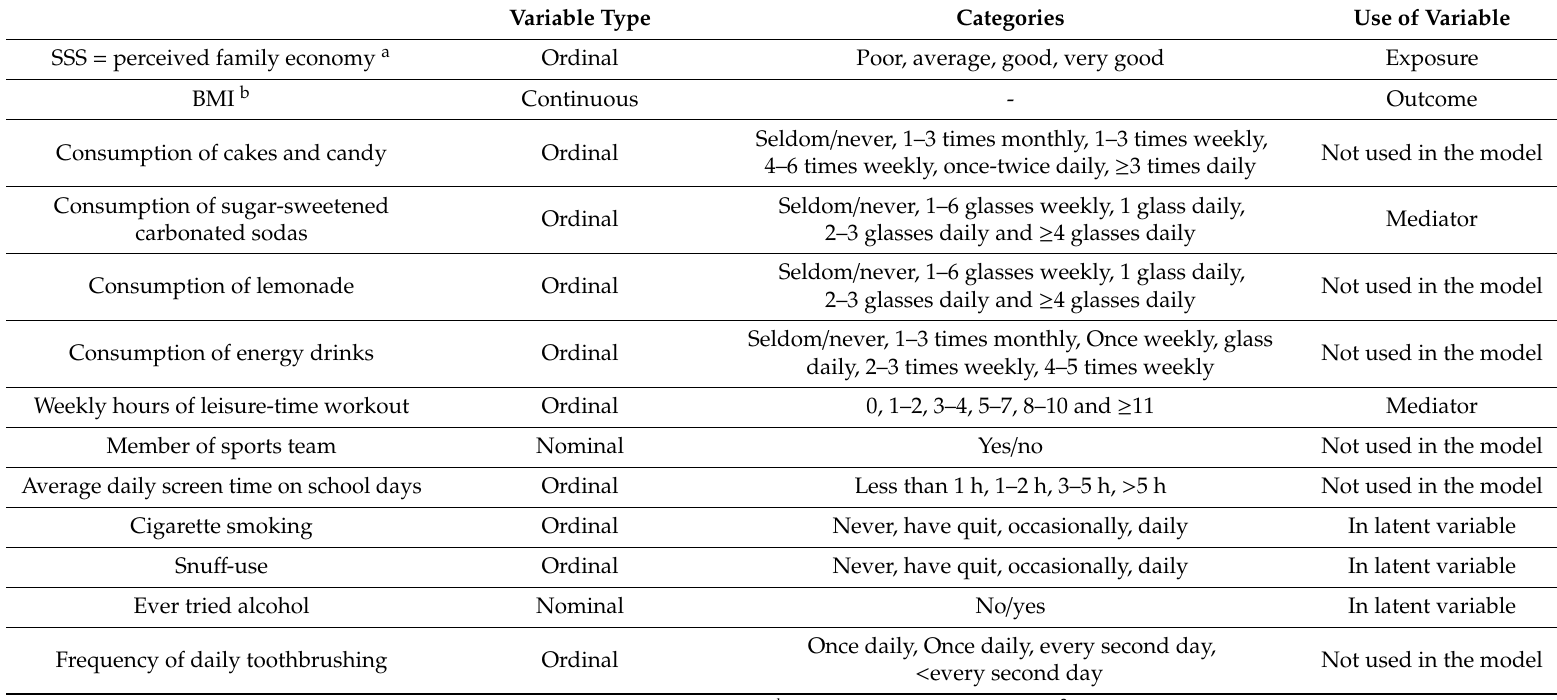
Table A1. Description of the variables explored in the SEM for 15–16-year-old adolescents in the District of Oppland, Norway in